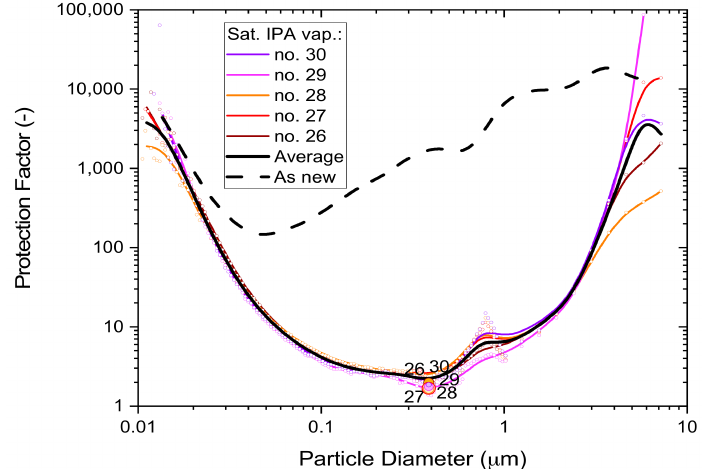
Figure 6. The particle size dependence of the protection factor of five P2-SD disposable respirator masks (Shanghai Da Sheng, box 3) after 5-h exposure to saturated IPA vapors; results from non- destructive testing are shown as circular dots with corresponding coloring at 0.39 µ m particle size. The average performance is shown by the black solid line and the performance of an unused mask (as new) is shown for comparison by the black dashed